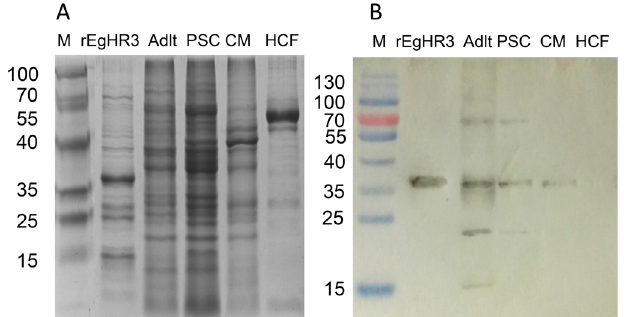
Figure 4. SDS-PAGE and Western blot analysis of EgHR3-like protein. SDS-PAGE analysis of recombinant His-EgHR3 (rEgHR3), E. granulosus soluble protein extracts from adult worms (Adult), protoscoleces (PSCs), cyst germinal layer membranes (CMs) and hydatid cyst fl uid (HCF) (A). Western Blot analysis (using mouse anti-rEgHR3 antiserum). Protein markers are indicated in kDa